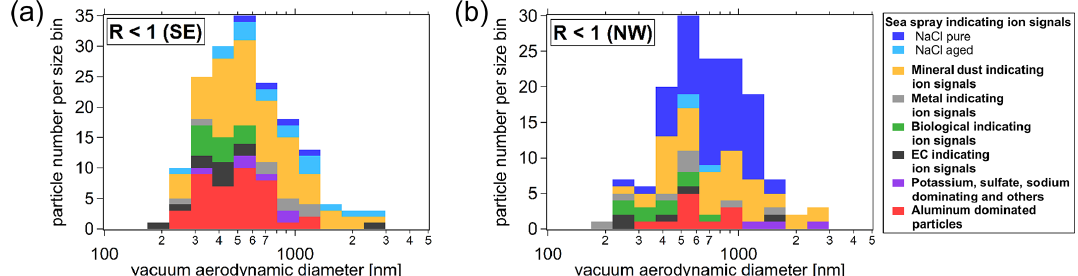
Figure 10. Size-resolved particle number fraction of the determined IPR types for cloud periods with higher proportion ( R < 1) of small IPR ( < 300nm), which is interpreted as a higher contribution of secondary ice (see description in Sect. 3.5.1), selected by southeasterly flow (a) and northwesterly flow (b)